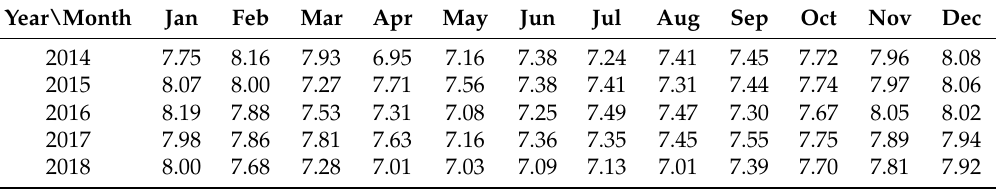
Figure A17. Monthly means of salinity at sea surface for separated years. January to June. Table A7. Monthly maximums for surface salinity for the years 2014–2018.